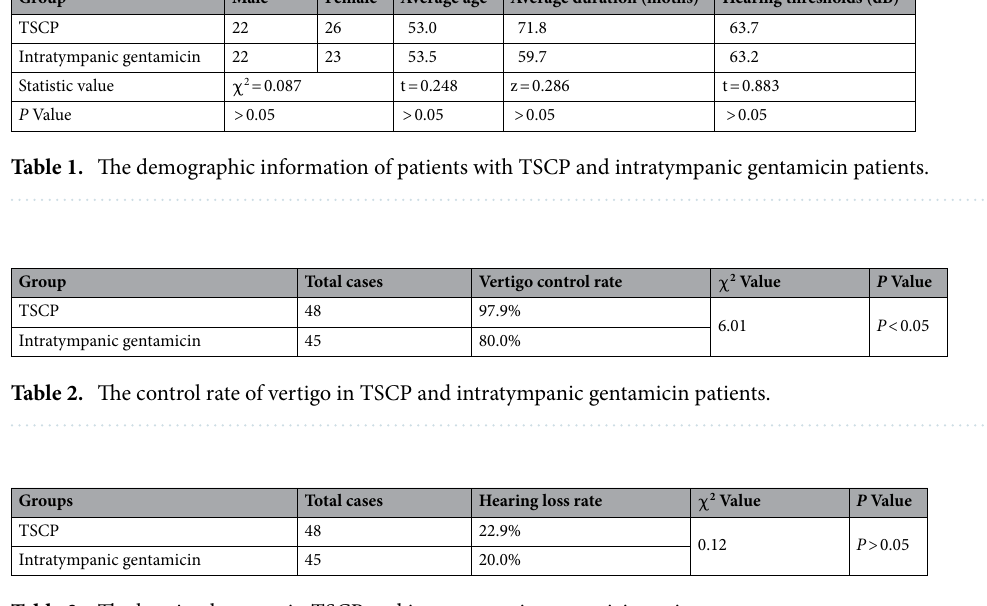
Table 3. The hearing loss rate in TSCP and intratympanic gentamicin patients.